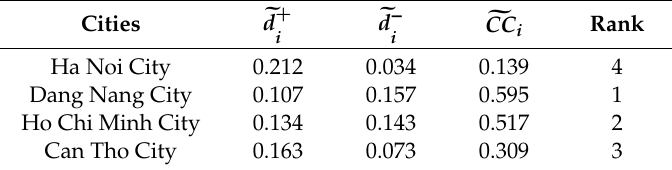
Table 18. Closeness coe ffi cients and rank of alternatives for environmental